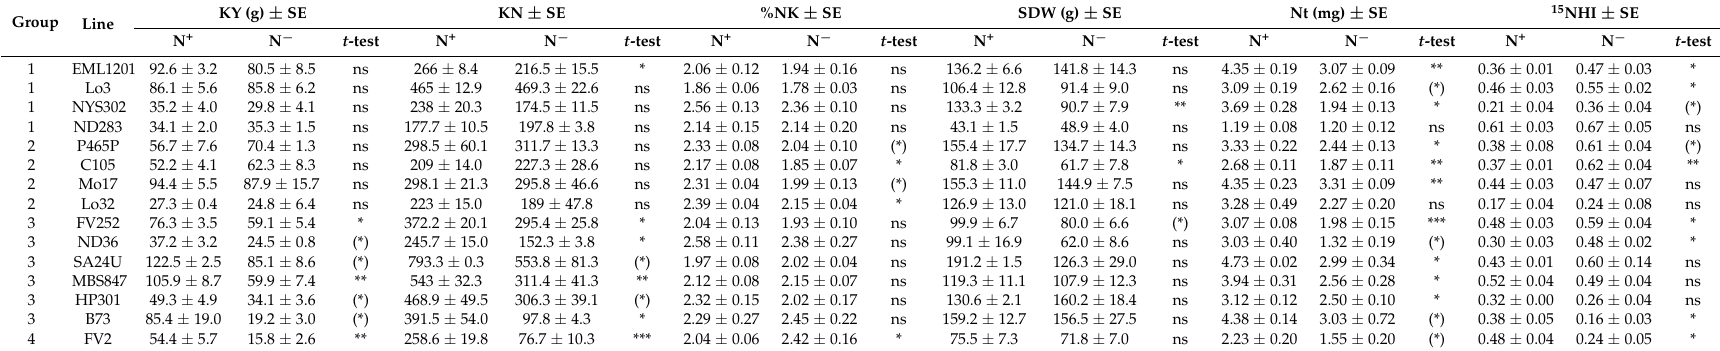
Table 1. Agronomic performance and nitrogen management of the core collection of 15 maize inbred lines originating from Europe and America. Group